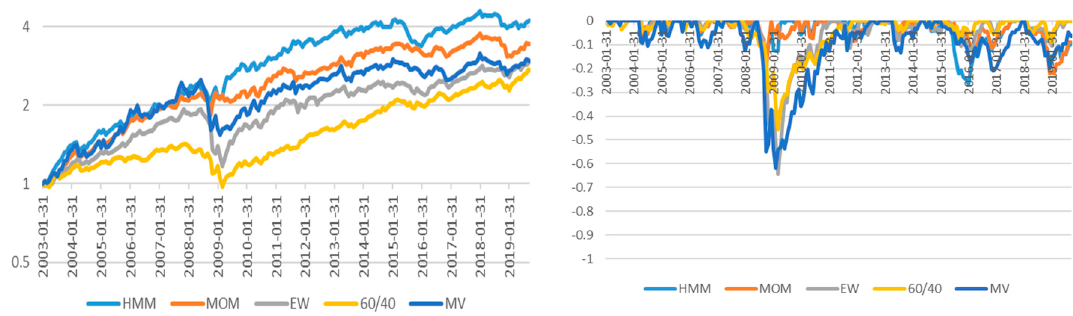
Figure 6. Portfolio Return and Drawdown Chart of Asset 10.